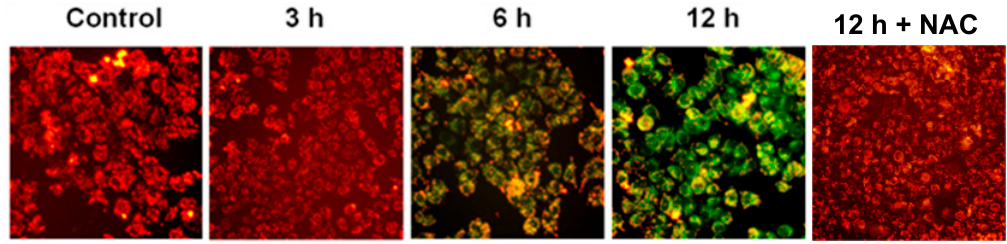
Figure 6. ATL treatment disrupted mitochondrial membrane potential. SW480 cells were treated with 20 μ M ATL for 0.5, 1, 3, 6, 12, and 24 h or 20 μ M ATL plus 5 mM NAC for 12 h, significant dissipation of mitochondrial membrane potential became evident after ATL treatment for 6 h and 5 mM NAC blocked the of mitochondrial membrane potential (scale bar = 50 μ m).